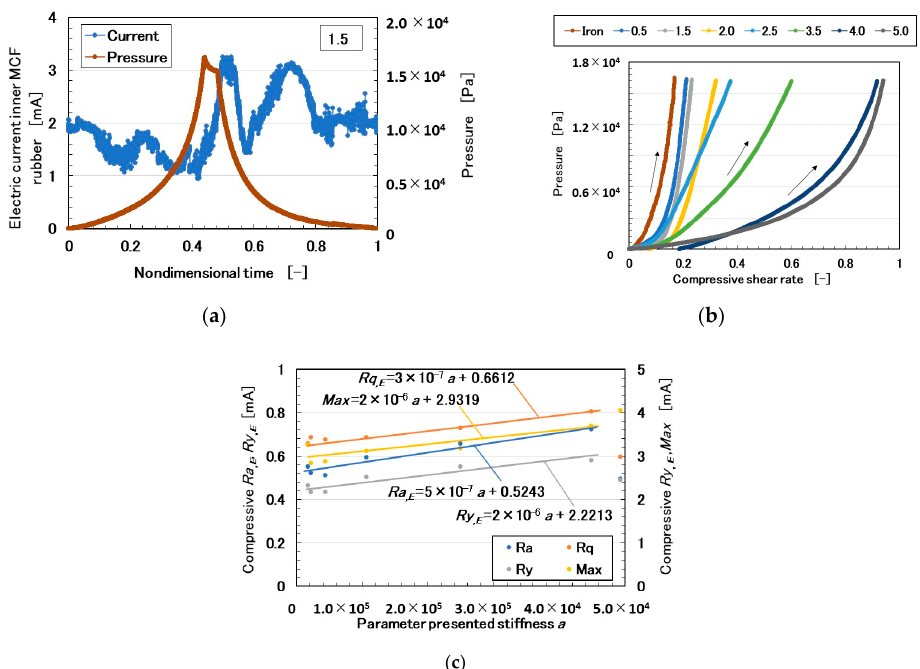
Figure 12. Results of the silicone gel in contact with the MCF rubber sensor under compression: ( a ) ( a ) electric current and pressure with a ratio of involving thinner to KE1300T at 1.5; ( b ) relationship between pressure and compressive shear rate at various ratios of the thinner to KE1300T; ( c ) relationship of Ra ,E , Rq ,E , Ry ,E , and Max to the parameter presented sti ff ness a